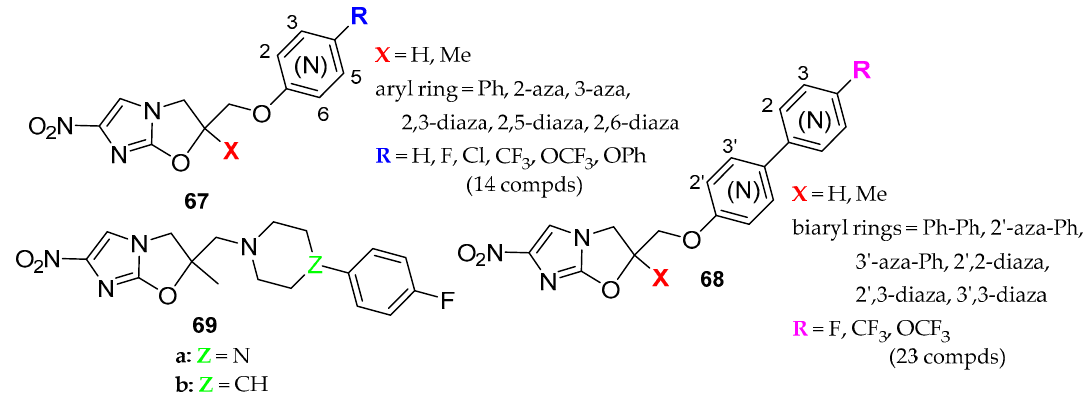
Figure 17. 6-Nitroimidazooxazoles ( 67 – 69 ) for visceral leishmaniasis.